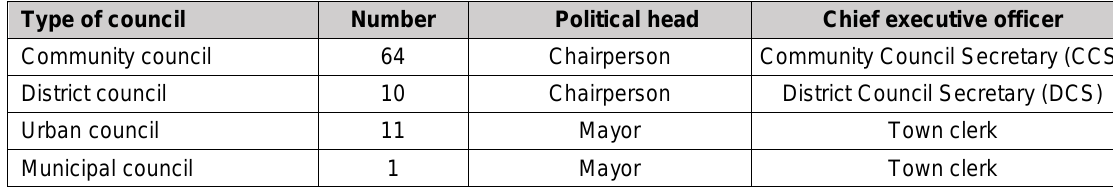
Table 2: Administrative staff of councils Type of